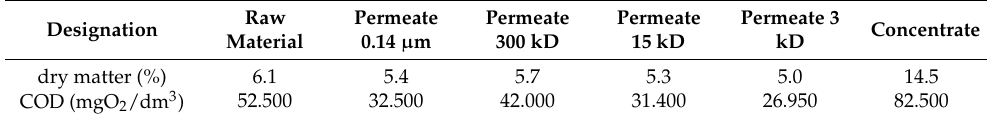
Table 7. The parameters of sewage